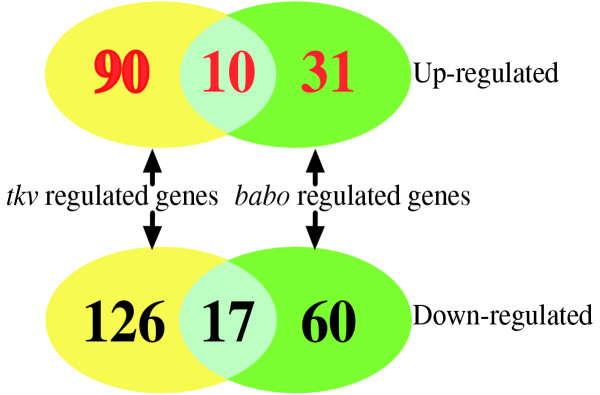
Distribution of differential regulated genes by ecotopic expression of tkv and babo. Upon ectopic expression of tkv, 60 transcripts are downregulated and 31 are upregulated. Similarly, at ectopic expression of babo, we detected 216 genes with differential expression values in brain tissues and expression levels of 126 transcripts are decreased and 90 transcripts are increased. There are 27 genes coregulated at ectopic expression of both babo and tkv. 17 of these transcripts are downregulated and 10 of transcripts are upregulated.